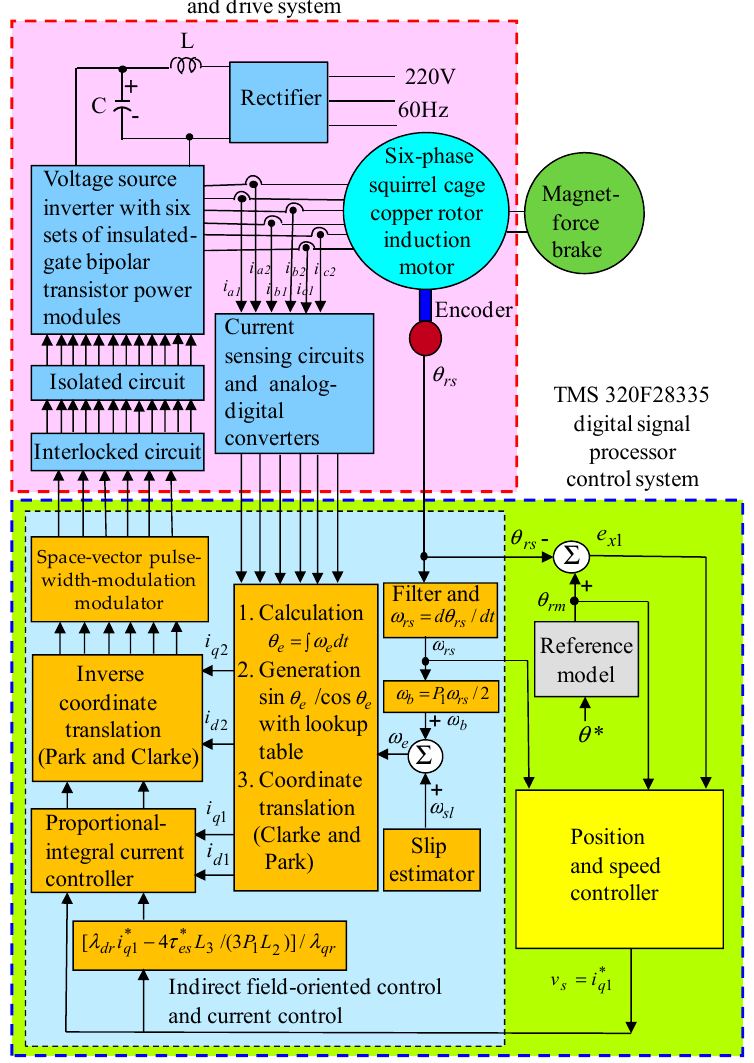
Figure 1. Conformation of the indirect field-oriented control of the six-phase squirrel cage copper rotor induction motor drive system with a digital signal processor control system.